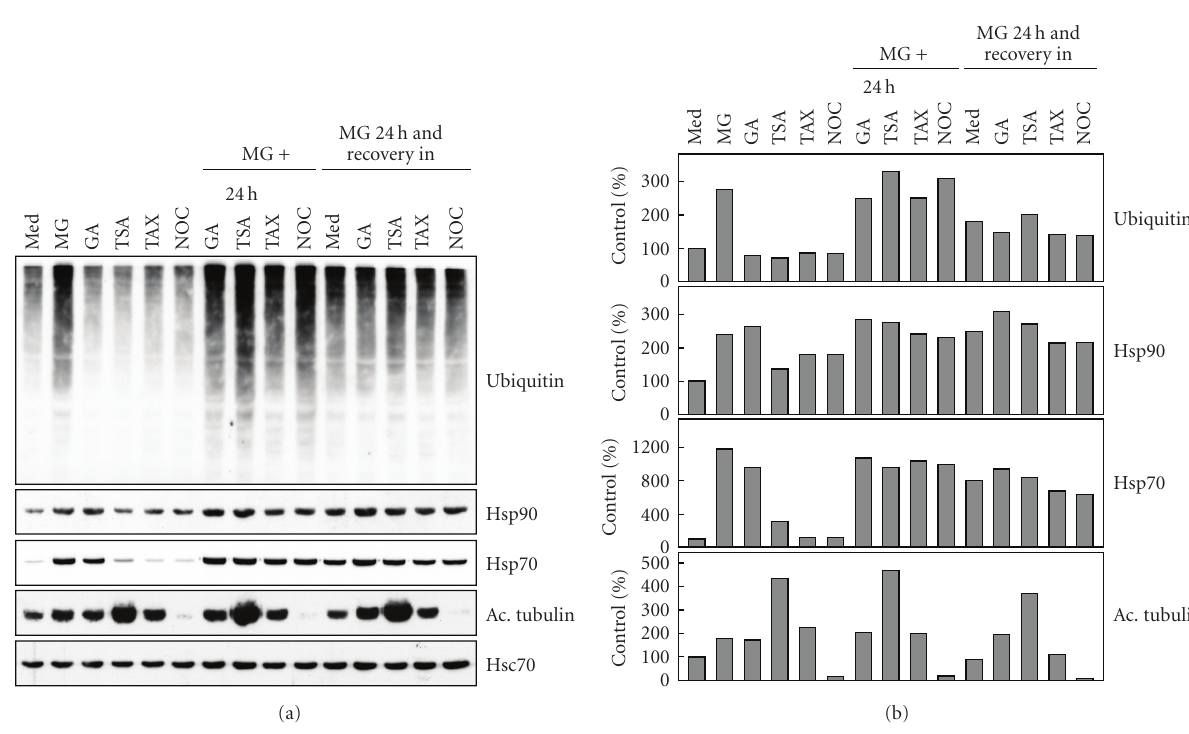
Figure 3: (a) Total proteins (20 μ g) of whole cell extracts were examined by western blot using antibodies against ubiquitin, Hsp90, Hsp70, acetylated tubulin, and Hsc70 of control (C) cells, and cells exposed to 5 μ M MG-132 (MG) or 0.25 μ M geldanamycin (GA) or 1 μ M trichostatin A (TSA) or 1 μ M taxol (TAX) or 5 μ M nocodazole (NOC) for 24 hours. In addition, the cells were treated simultaneously with GA or TSA or TAX or NOC and MG-132 for up to 24 hours and then allowed to recover under the indicated conditions for 24 hours. Hsc70 was used to check the equal loading of proteins. (b) Quantifications of western blots.